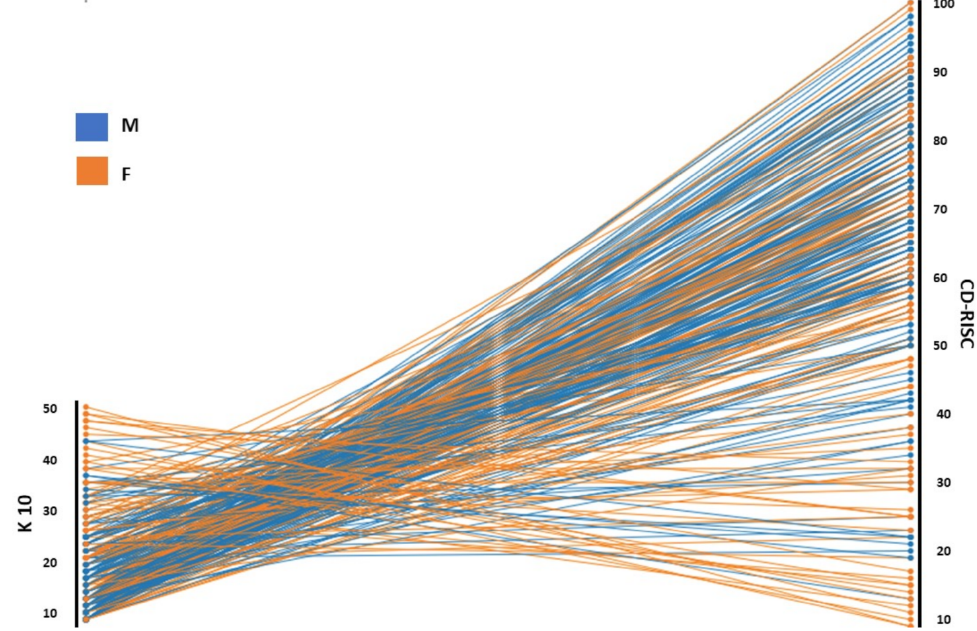
Figure 1. Relationship between resilience factors and risk of psychopathology. Abbreviations: K-10, Kessler Psychological Distress Scale; CD-RISC, Connor-Davidson Resilience Scale; M, men; F,